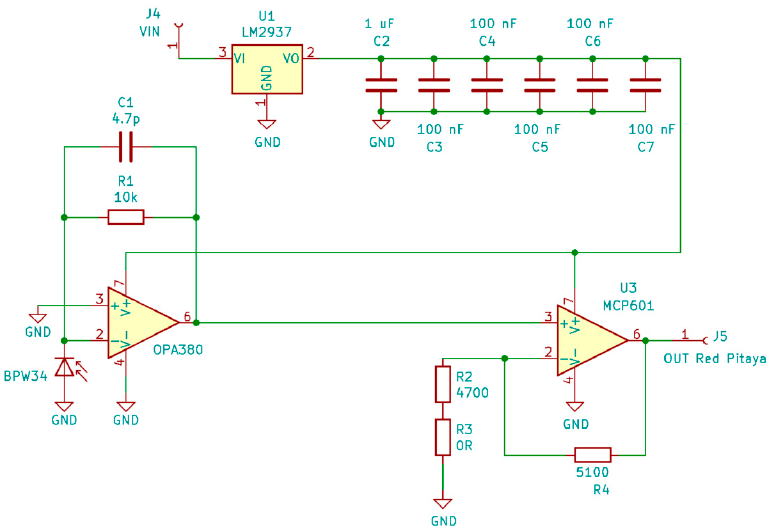
linear voltage regulator [10].